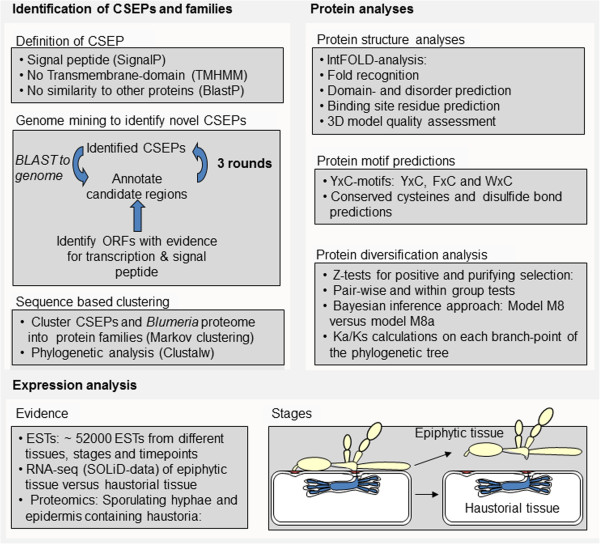
Summary of bioinformatics and expression analysis of CSEPs. Identification of CSEPs and family assignment. Workflow used to find and annotate CSEPs in the genome of B. graminis f.sp. hordei. After three iterative rounds of BLAST and annotation, genes were clustered into families as described in Methods. Protein analyses. The proteins predicted to be translated from the CSEP ORFs were analyzed to infer their 3D structure and presence of conserved motifs. These were then used to investigate evidence of different selection pressures during the course of evolution of the CSEP families. Expression analysis. Evidence to support the existence of CSEP genes was obtained from ESTs in the public databases, from RNAseq surveys and from the analysis of the proteomes of B. graminis and B. graminis-infected barley tissues by mass-spectrometry.